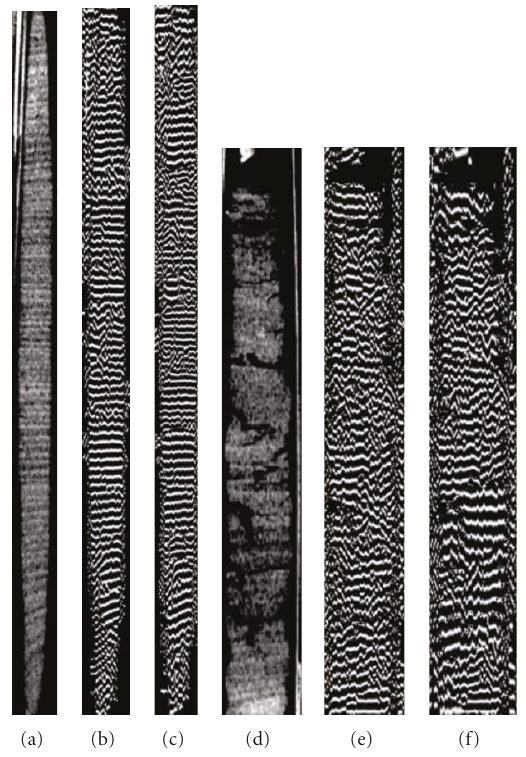
Figure 12: Examples of best and worst result samples for di ff erent filterbank specifications. Best FM for uniformspacing filterbank results are presented in (a) to (c). (a) Original image. (b) FM image using variable frequency filterbank. (c) FM image using uniform spacing filterbank. The variable frequency spacing filterbank gave a 1.27% error and the uniform spacing filterbank gave a 0% error, meaning it detected all 79 rings. Worst FM for uniform spacing filterbank results are presented in (d) to (f). (d) Original image (2nd example). (e) FM image using variable frequency spacing filterbank (f) and uniform wavelength spacing filterbank. In this second example, the variable frequency spacing filterbank gave a 2.17% error and the uniform spacing filterbank gave a 13% error, meaning it detected only 40 out of 46 rings.